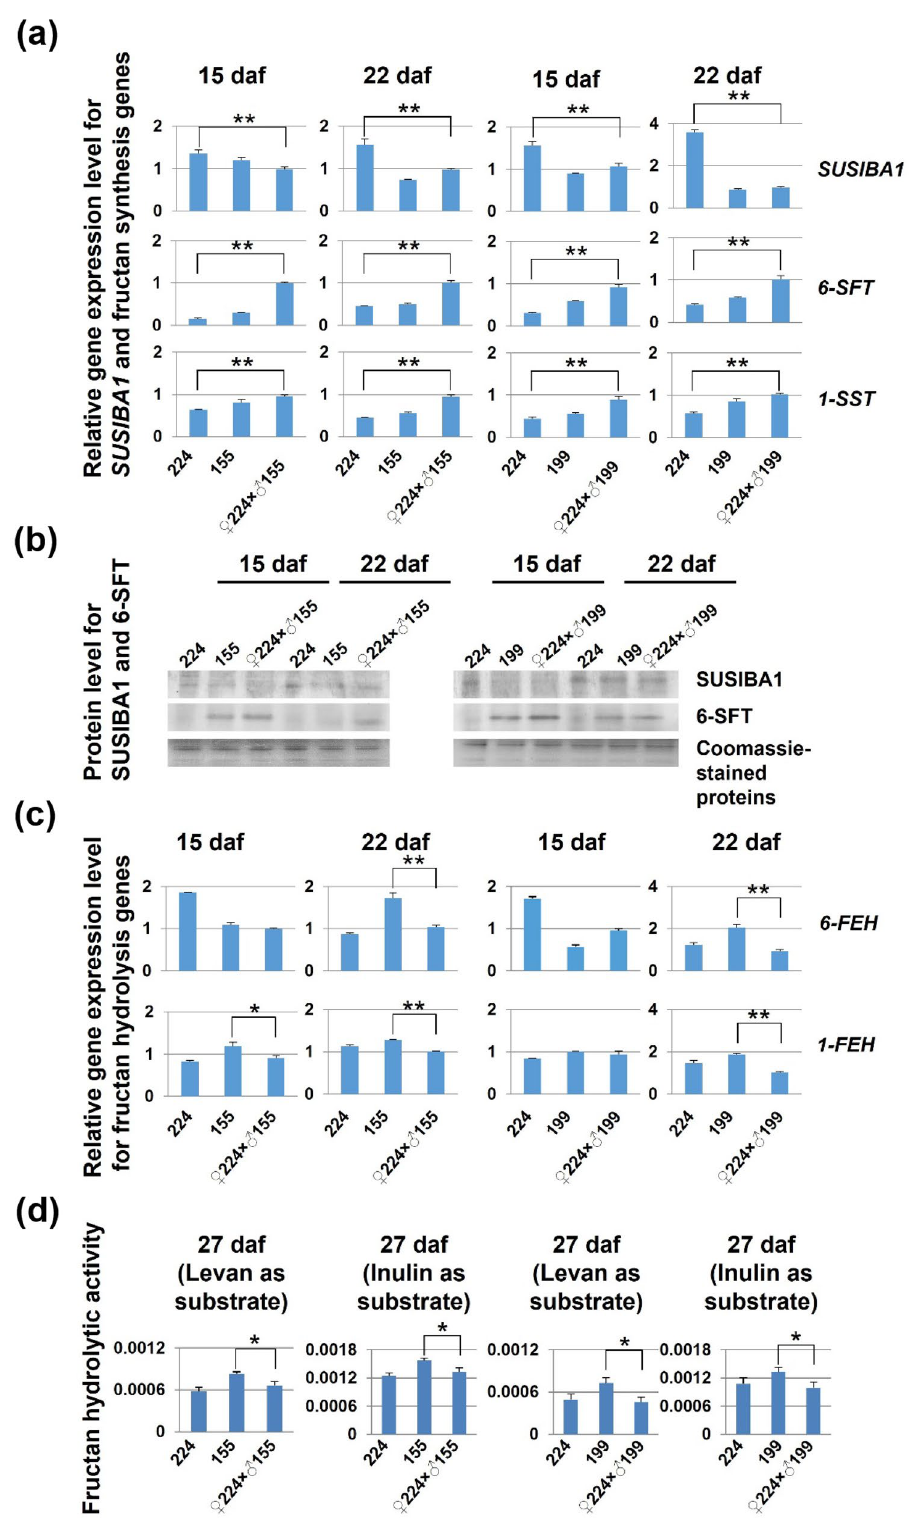
Figure 3. Gene and protein expression during grain development in F 3 progenies after crossing. ( a ) Results of quantitative real-time PCR (qPCR) analysis of relative gene expression levels of a fructan negative transcription factor gene, SUSIBA1 , and two fructan synthesis genes, 6-SFT and 1-SST at 15 and 22 days after flowering (daf). ( b ) Western blot analysis of proteins SUSIBA1 and 6-SFT in the corresponding samples in ( a ), and uncropped images are placed in Supplementary Fig. S2. ( c ) Results of qPCR analysis of relative gene expression levels for two representatives of fructan hydrolysis genes, 6-FEH and 1-FEH , at 15 and 22 daf. ( d ) Assayed enzyme activity of 6-FEH (levan as substrate) and 1-FEH (inulin as substrate) at 27 daf. Enzyme activity expressed as mg of fructose formation per min at 25 °C. Student’s t-test was used (Error bars show SD). * P < 0.05 and ** P < 0.01 are shown for significant differences between the progenies and the parent of interest. Three biological replicates or grains from three independent plants ( n = 3) were used for qPCR analysis and two biological replicates for Western blot